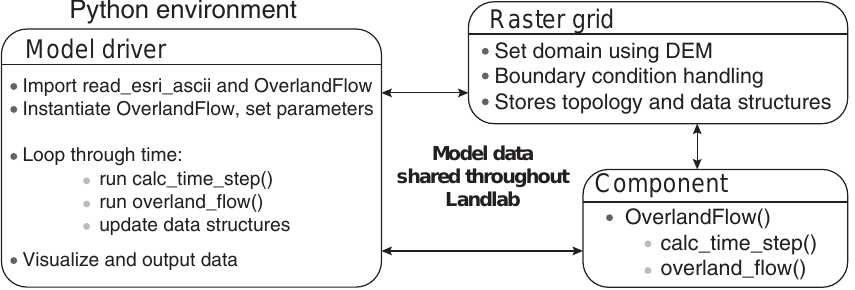
Figure 2. Sample workflow for the Landlab OverlandFlow component. Users create or adapt a pre-developed model driver, where the grid, components, and model utilities are imported and instantiated. The time loop is set in the driver, and at each time step the component methods are called and the data structures are